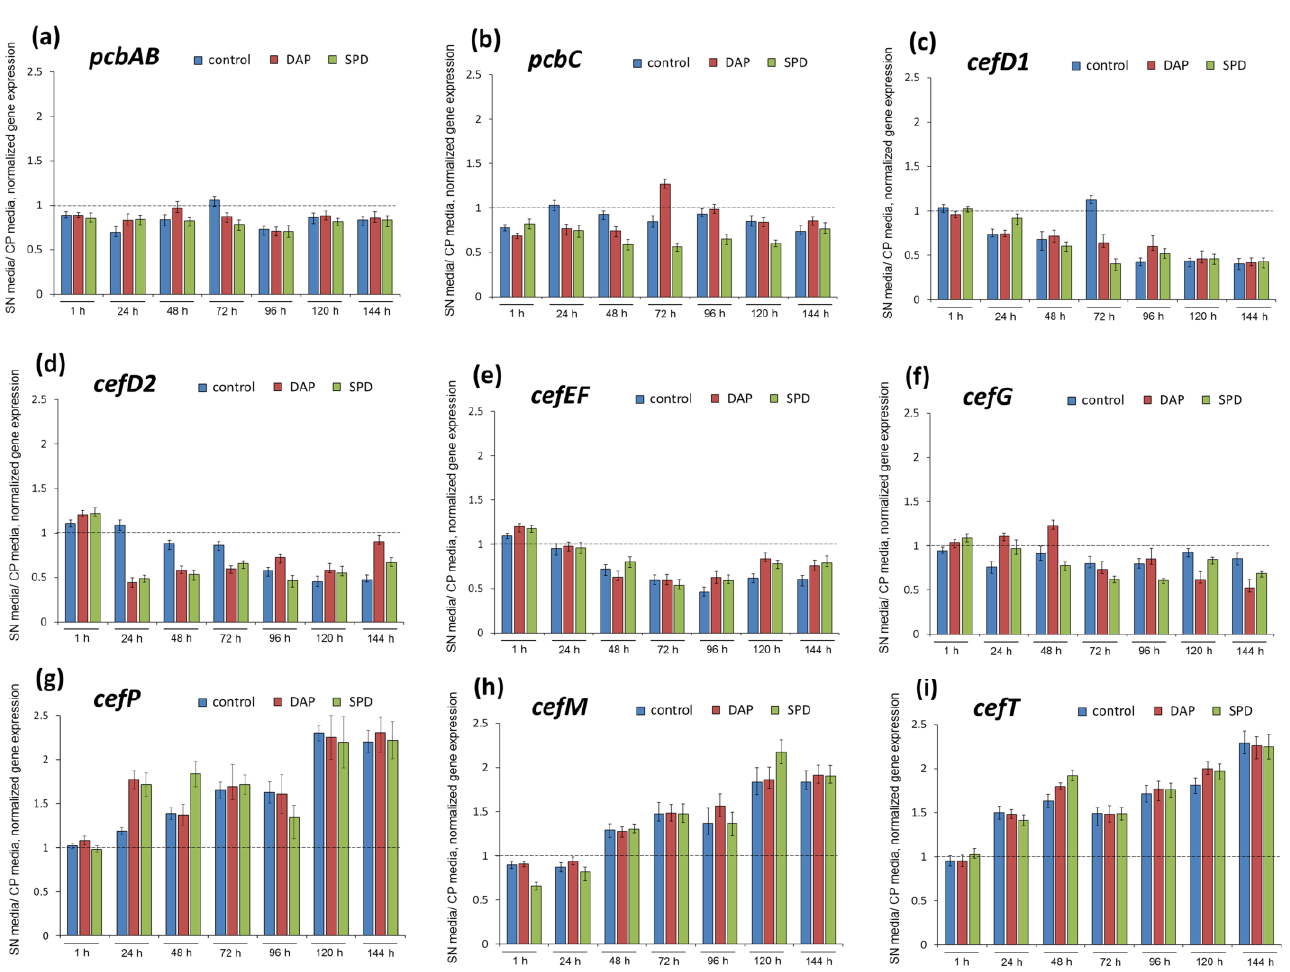
Figure 8. Relative expression on synthetic (SN)/ complex (CP) media for cef genes in A. chrysogenum high-yielding (HY) strain: ( a ) pcbAB ; ( b ) pcbC ; ( c ) cefD1 ; ( d ) cefD2 ; ( e ) cefEF ; ( f ) cefG ; ( g ) cefP ; ( h ) cefM ; ( i ) cefT . Samples were taken at 1 h, 24 h, 48 h, 72 h, 96 h, 120 h, and 144 h of cultivation A. chrysogenum HY on SN medium or CP medium, both supplemented with 5 mM 1,3-diaminopropane (DAP), or 5 mM spermidine (SPD), or without addition (control). The dashed lines show a comparative level of gene expression in the A. chrysogenum HY strain cultivated on CP medium. Data are means ± SD, n =